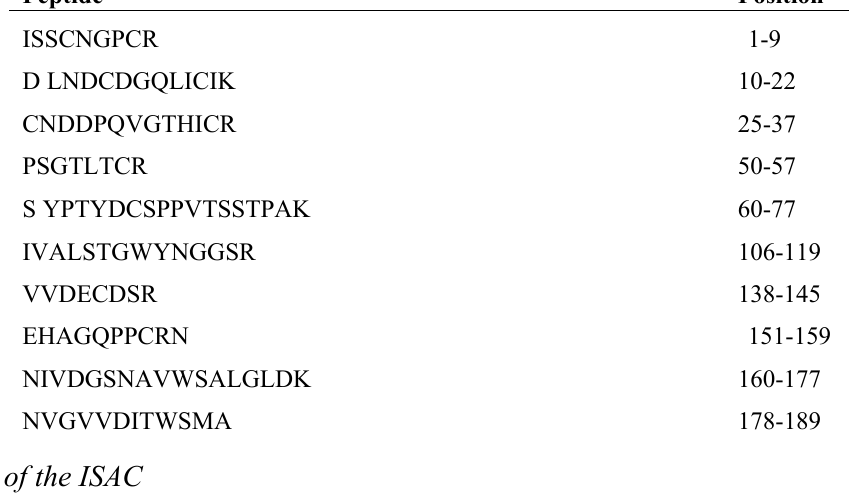
Table 4. Summary of peptide positions from Act d